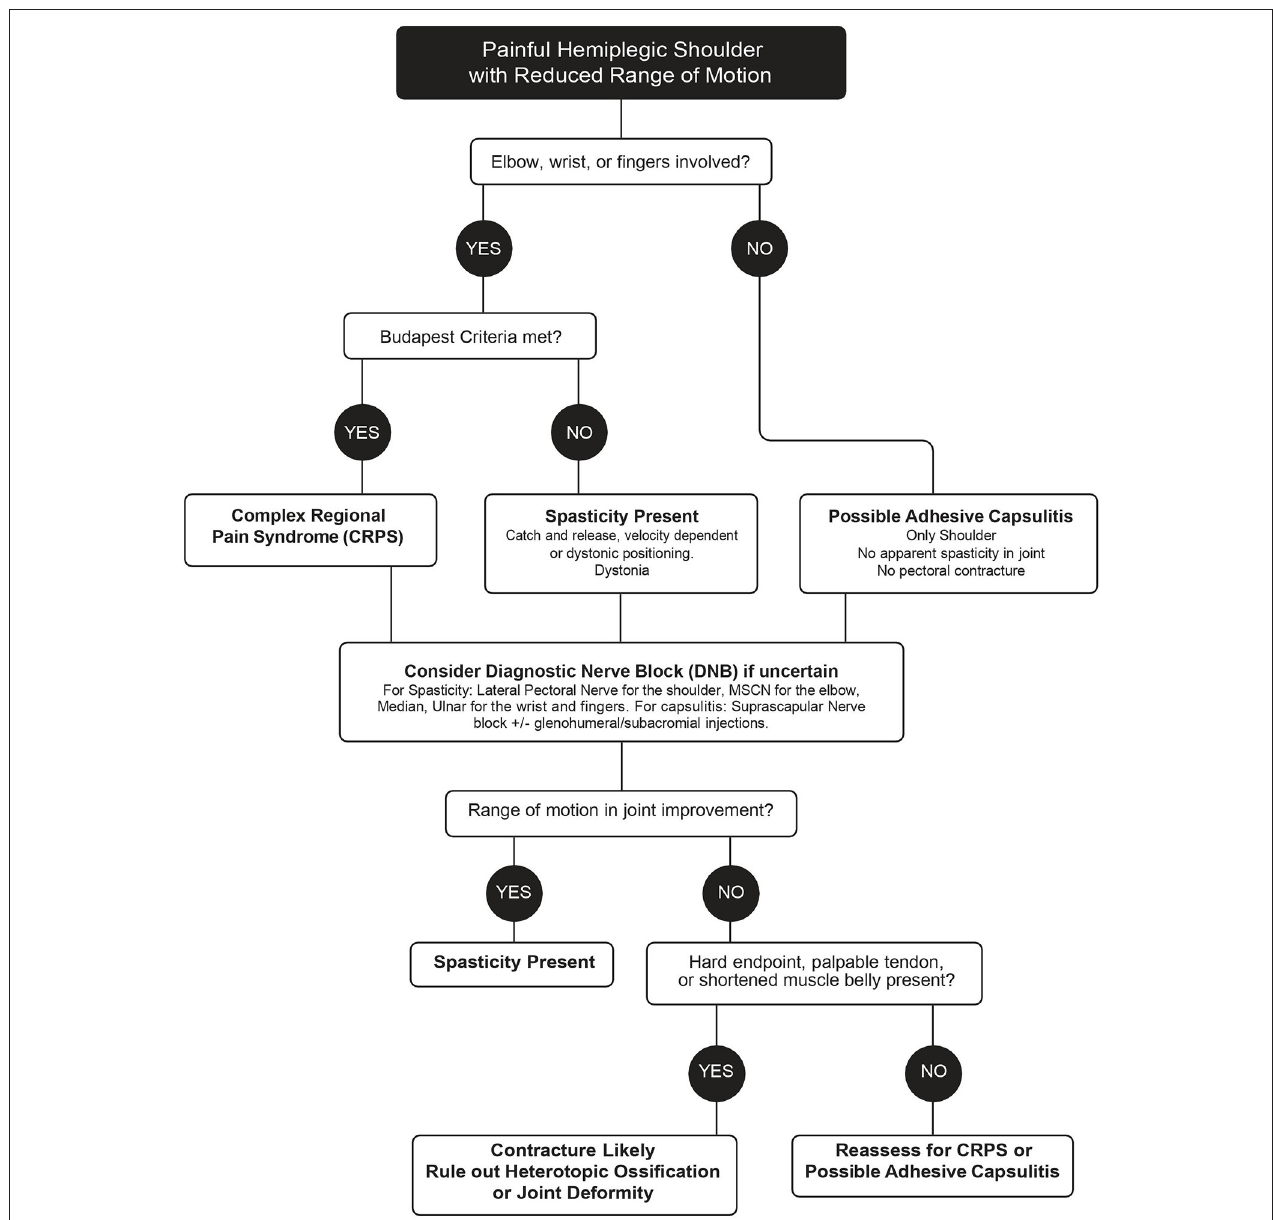
FIGURE 1 | ViVe treatment